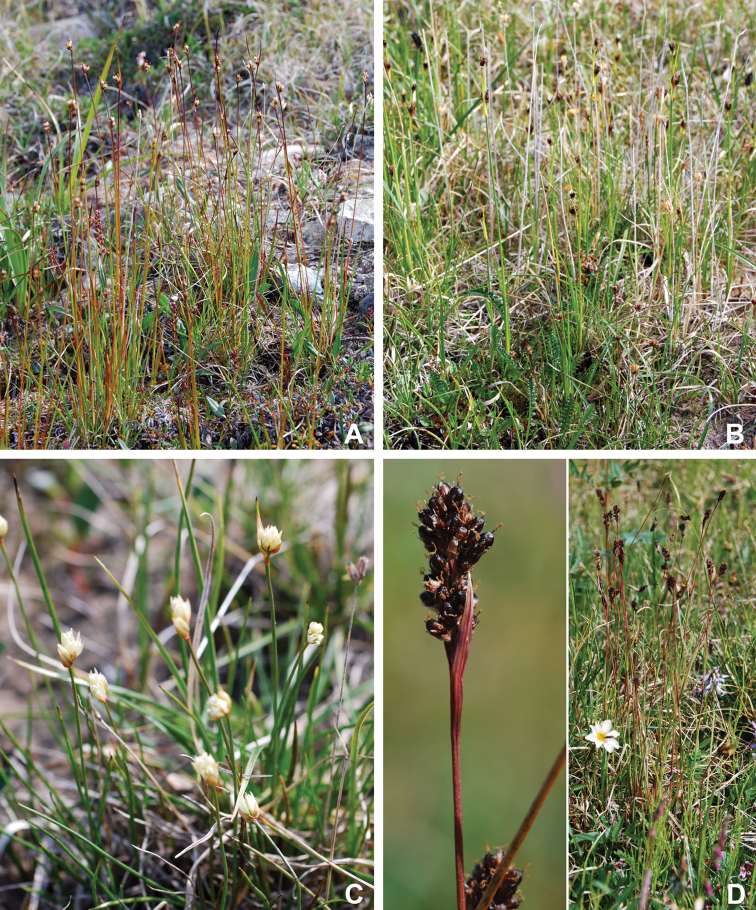
AJuncus
biglumis habit, Minto Inlet, NT, 22 July 2010 BJuncus
leucochlamys habit, Gillespie et al. 9901CJuncus
triglumis
subsp.
albescens habit, Gillespie et al. 9859DLuzula
nivalis inflorescence (left) and habit (right), Gillespie et al. 9667. Photos by J.M. Saarela.